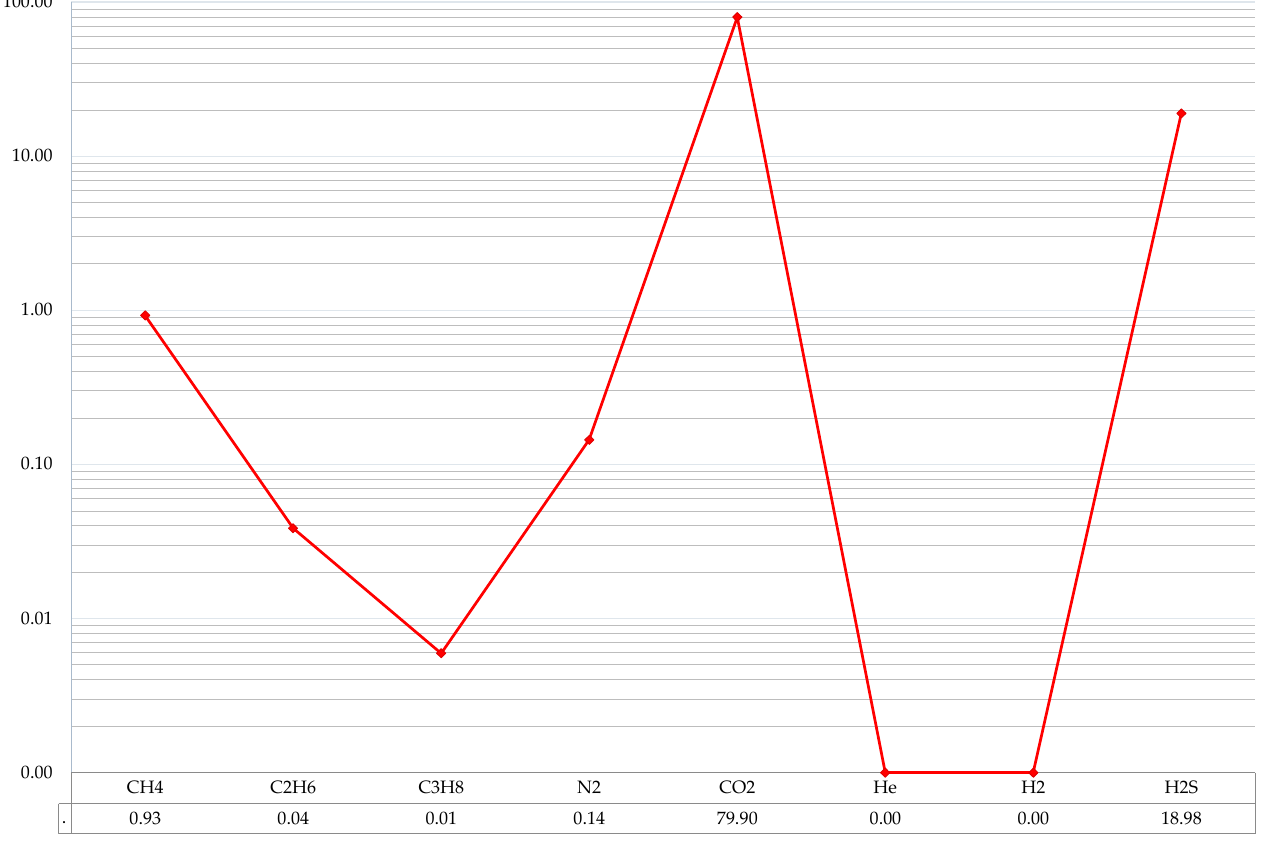
Figure 5. Current composition of the injected gas.